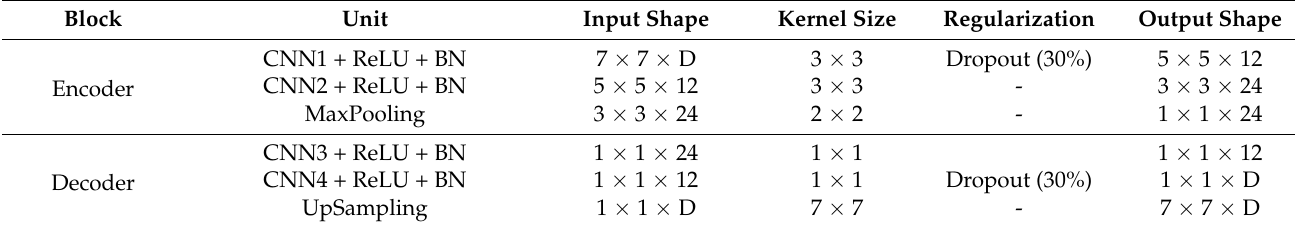
Table 5. The configuration of BCAE for the feature learning of the image path dataset with a 7 × 7 × D window size for the input